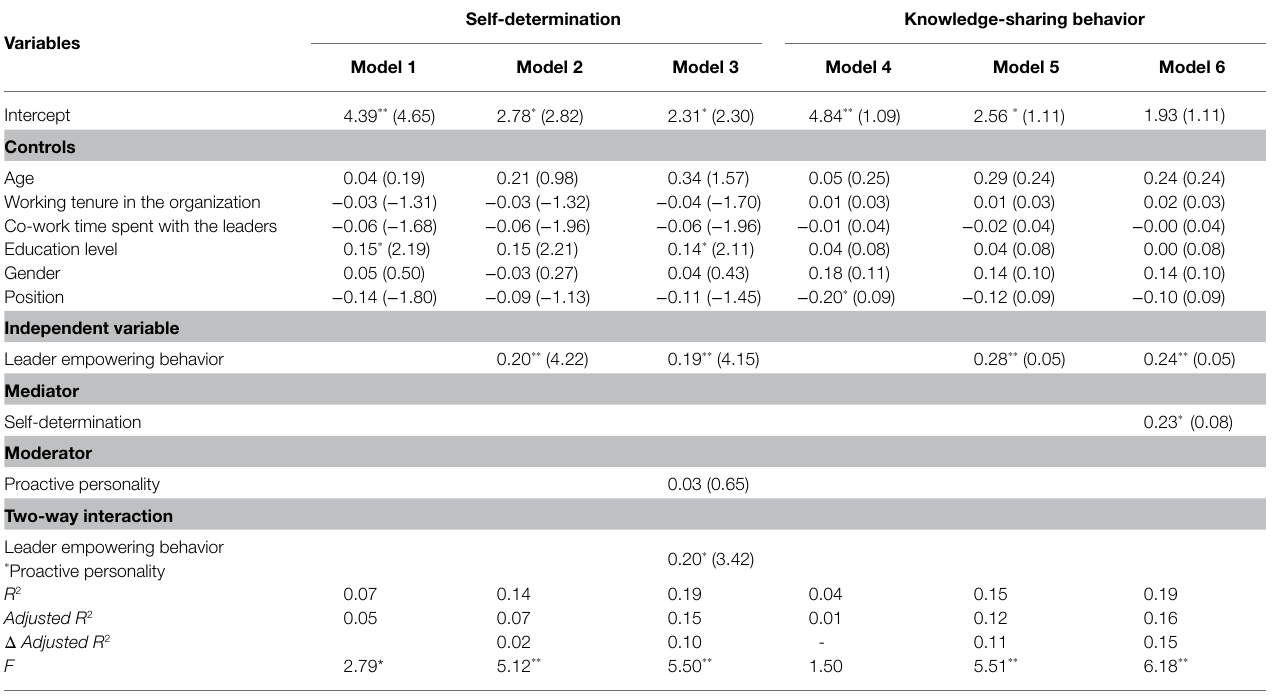
TABLE 3 | Ordinary least squares regression results.